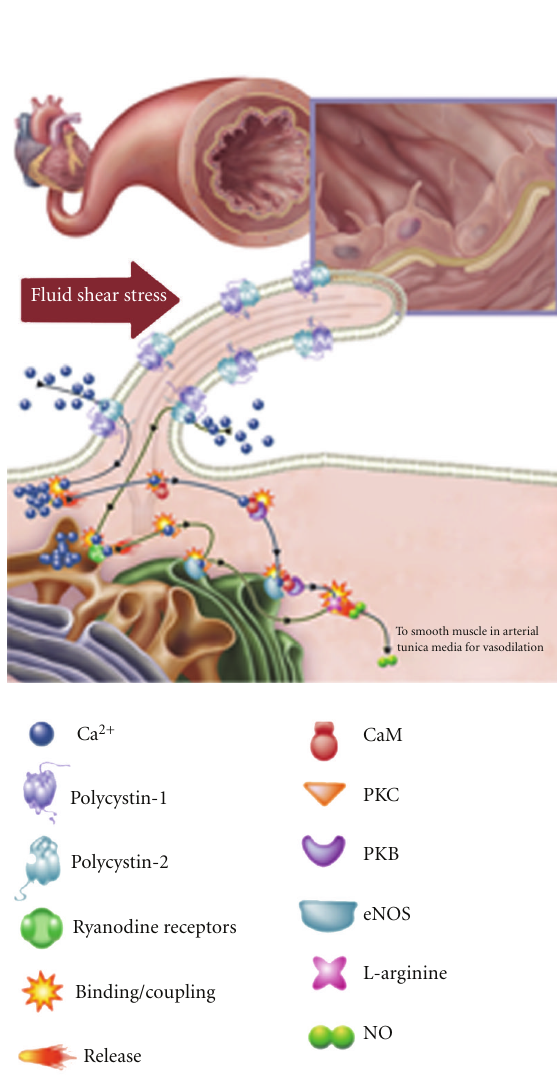
Figure 2: Mechanosensory cilia and nitric oxide production. The presence of cilia in vasculature plays an important role in the biochemical production of a potent vasodilator, nitric oxide (NO). The figure depicts the production of NO in an artery. Increases in blood pressure, which are translated to higher vascular shear stress, will be sensed by mechanosensory cilia.Bending or activation of the cilia involves mechanosensory polycystin-1 and polycystin-2 complex and a cascade of biochemical synthesis of NO. The cascade will further involve extracellular calcium influx (Ca 2+ ), followed by activation of various calcium-dependent proteins, including calmodulin (CaM) and protein kinase C (PKC). Akt/PKB, CaM, and PKC are important downstream molecular components to activate endothelial nitric oxide synthase (eNOS). This figure is reproduced with permission